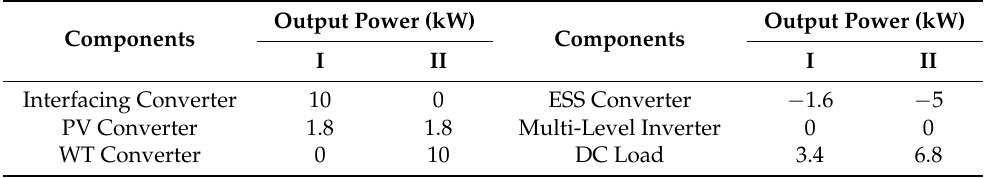
Table 9. Output power of each power conversion devices in mode 9.